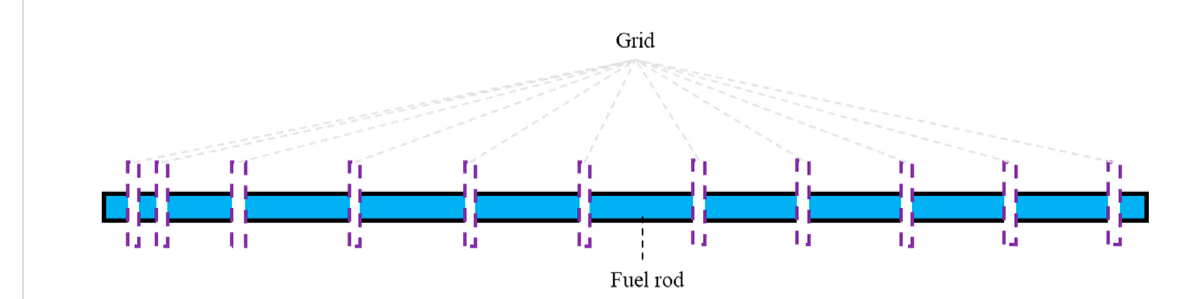
FIGURE 5 Schematic diagram of a multi-span continuous simply supported beam of EPR fuel rods.